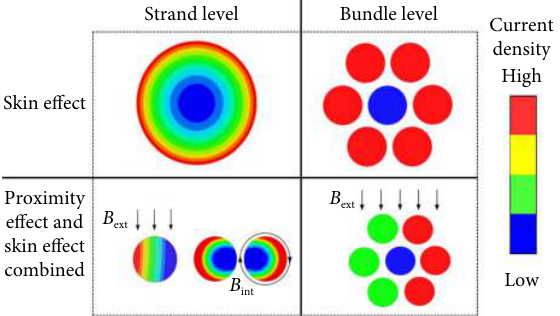
Fig. 5 Strand-level copper loss and bundle-level copper loss caused by the skin and proximity effect (reprinted with permission from Ref. [44], © 2021 IEEE).